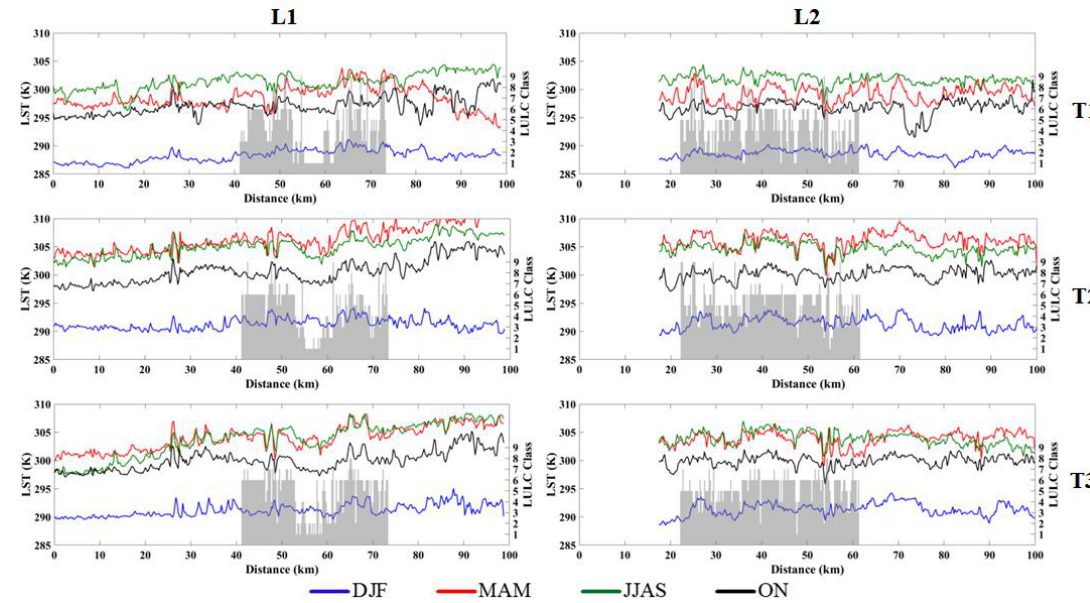
Figure 3. Spatial profile of LST (left y-axis) derived from Landsat dataset (30 m spatial resolution up-scaled to 250 m), varying with nine (1–9) categories of LULC classes (right y-axis, grey bars) for NE-SW (L1) and NW-SE (L2) transects for various seasons during time periods 1991–1999 (T1), 2000–2008 (T2), and 2009–2016 (T3). Representation of LULC classes is as follows: 1—Dense Forest, 2—Open